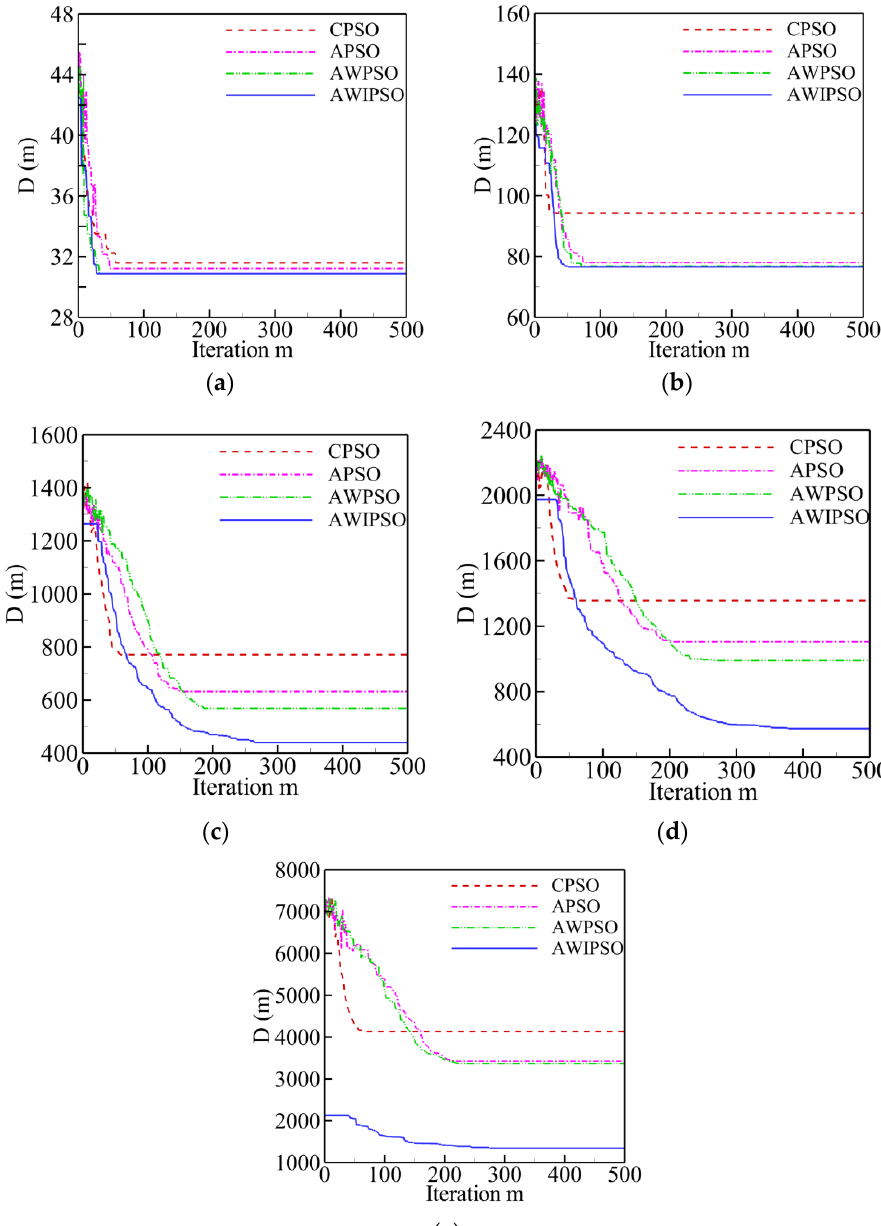
Figure 4. Evolution curves of optimal path distance against iterations for each algorithm: ( a ) Q = 14; ( b ) Q = 22; ( c ) Q = 51; ( d ) Q = 76; ( e ) Q = 99. Table 4. Simulating results of computing efficiency for each algorithm.